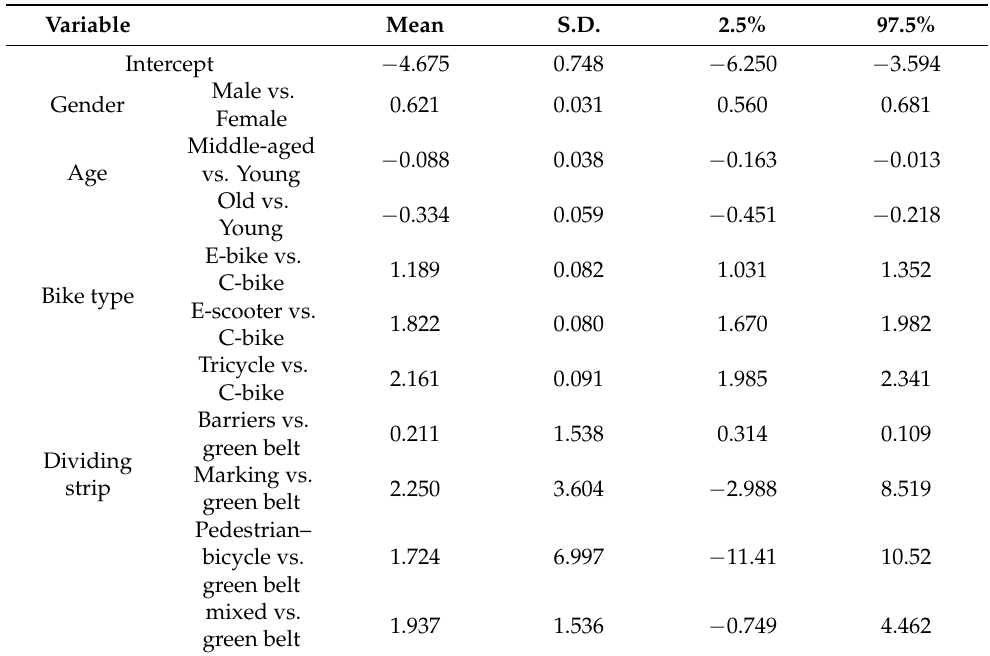
Table 3. Estimation from the standard logit